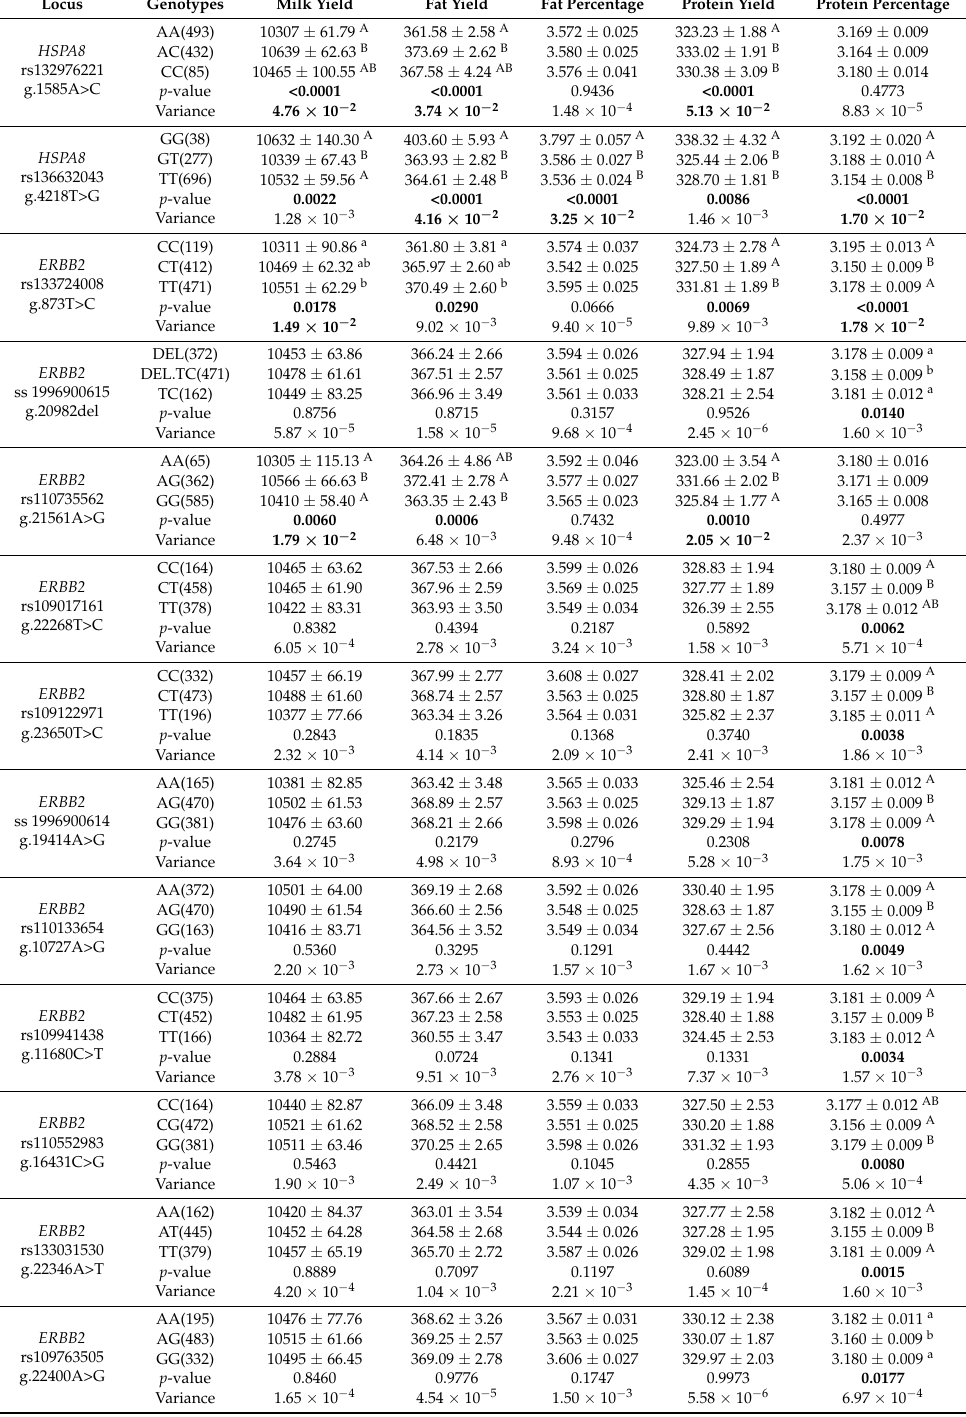
Table 3. Associations of identified SNPs of HSPA8 and ERBB2 genes with milk production traits in Chinese Holstein cattle (Least square mean ± Standard error, LSM ±